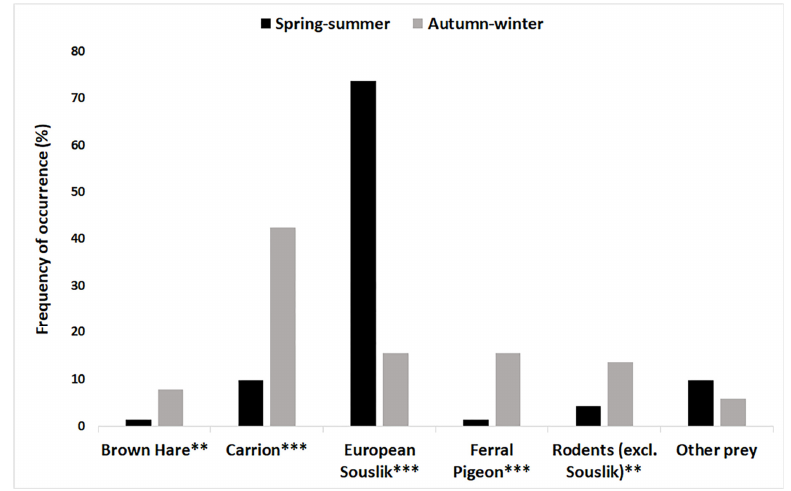
Figure 3. Results of the foraging of non-territorial Eastern Imperial Eagles in different habitat types.